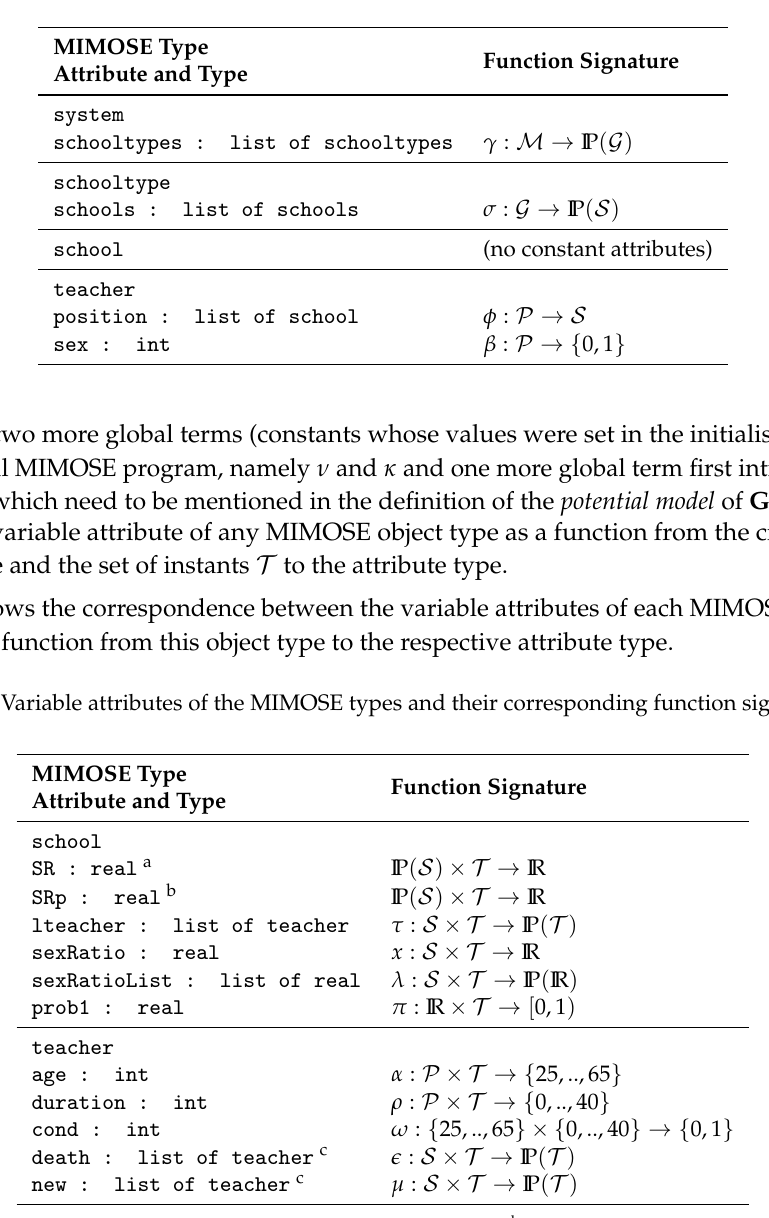
Table 2. Constant attributes of the MIMOSE types and their corresponding function signatures.